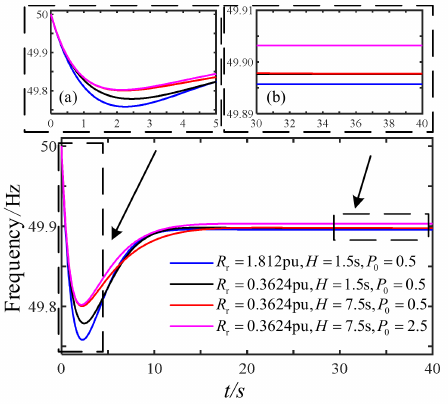
Figure 11. The influence of three parameters on the equivalent inertia of asynchronous motor. ( a ) The maximum rate of change of frequency; ( b ) The steady-state frequency